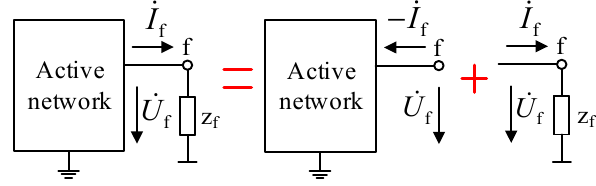
Figure 8. Equivalent network for symmetrical short-circuit analysis.